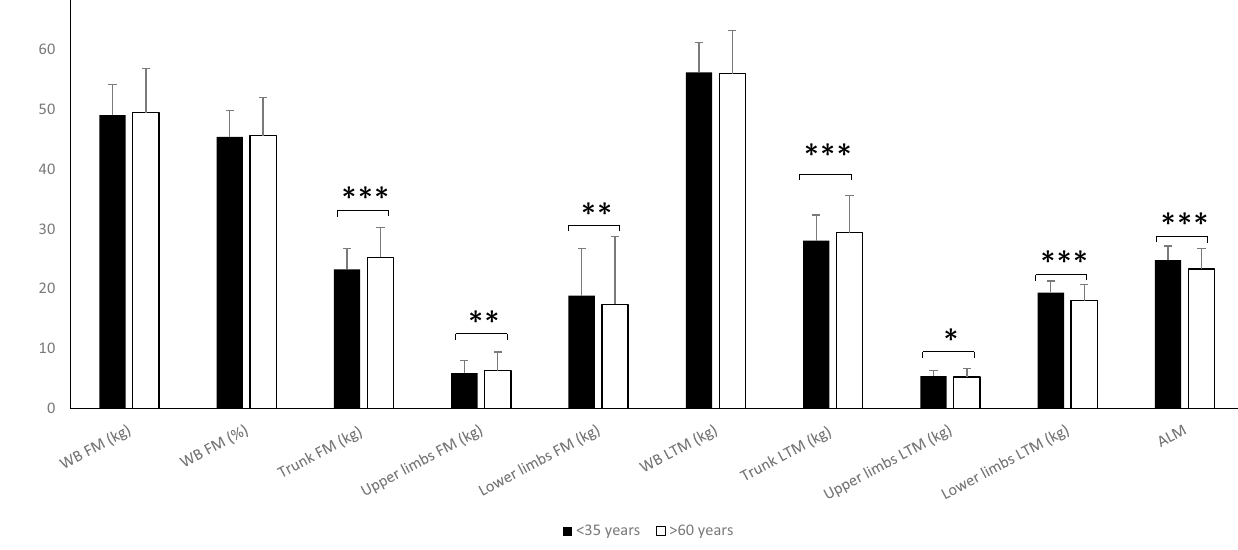
Figure 2. Comparision of fat mass and lean tissue mass adjusted on weight and height between young and older women with obesity. Data are presented as mean ± SD. WB: whole body; FM: fat mass; LTM: lean tissue